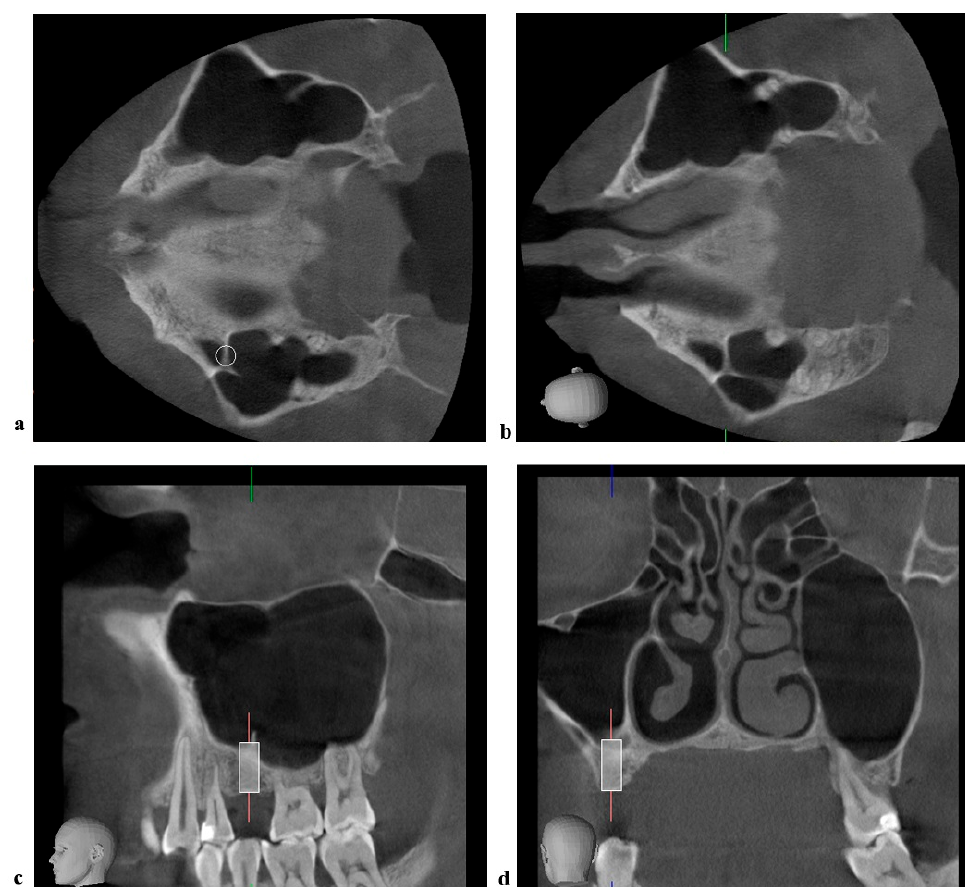
Figure 3. Combination of medio − lateral and antero − posterior septa (“Y” septum). ( a ) CBCT axial view of the left maxilla with simulation of implant placement. ( b ) CBCT axial view of the left maxilla revealing the “Y” septum. ( c ) CBCT sagittal view of the left maxilla with simulation of implant placement. ( d ) CBCT coronal view of the left maxilla with simulation of implant placement.